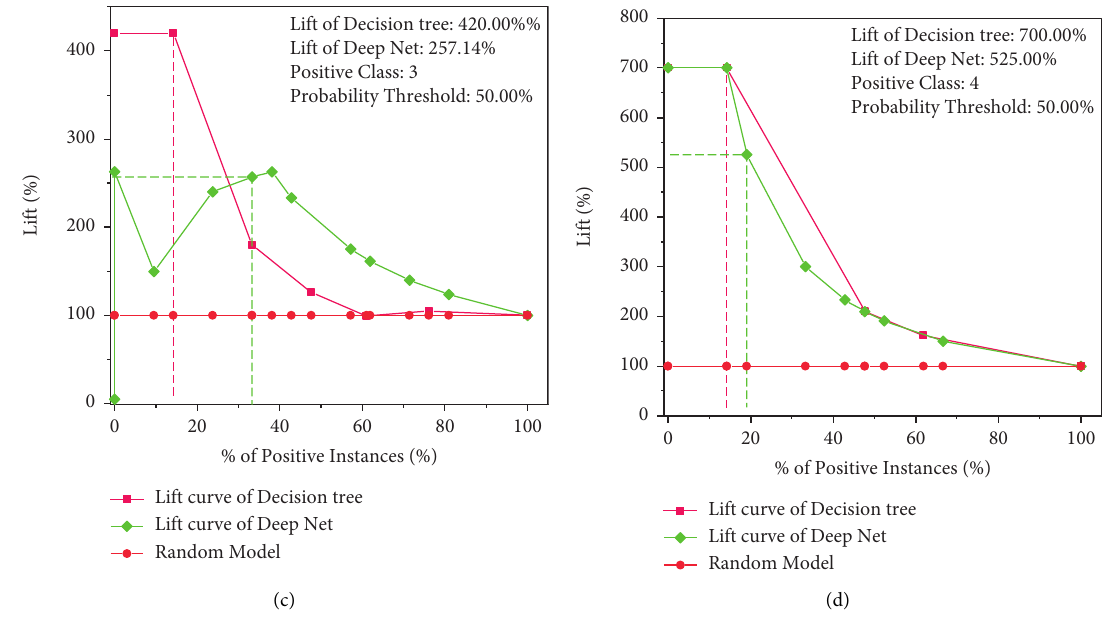
Figure 17: Lift curve of each classification test of the deep network